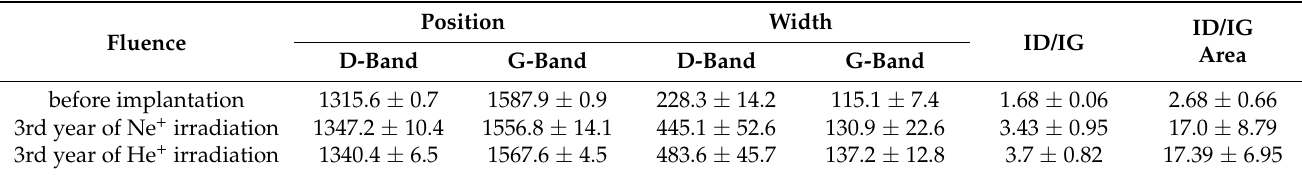
Table 4. S-3 outer surface implantation.